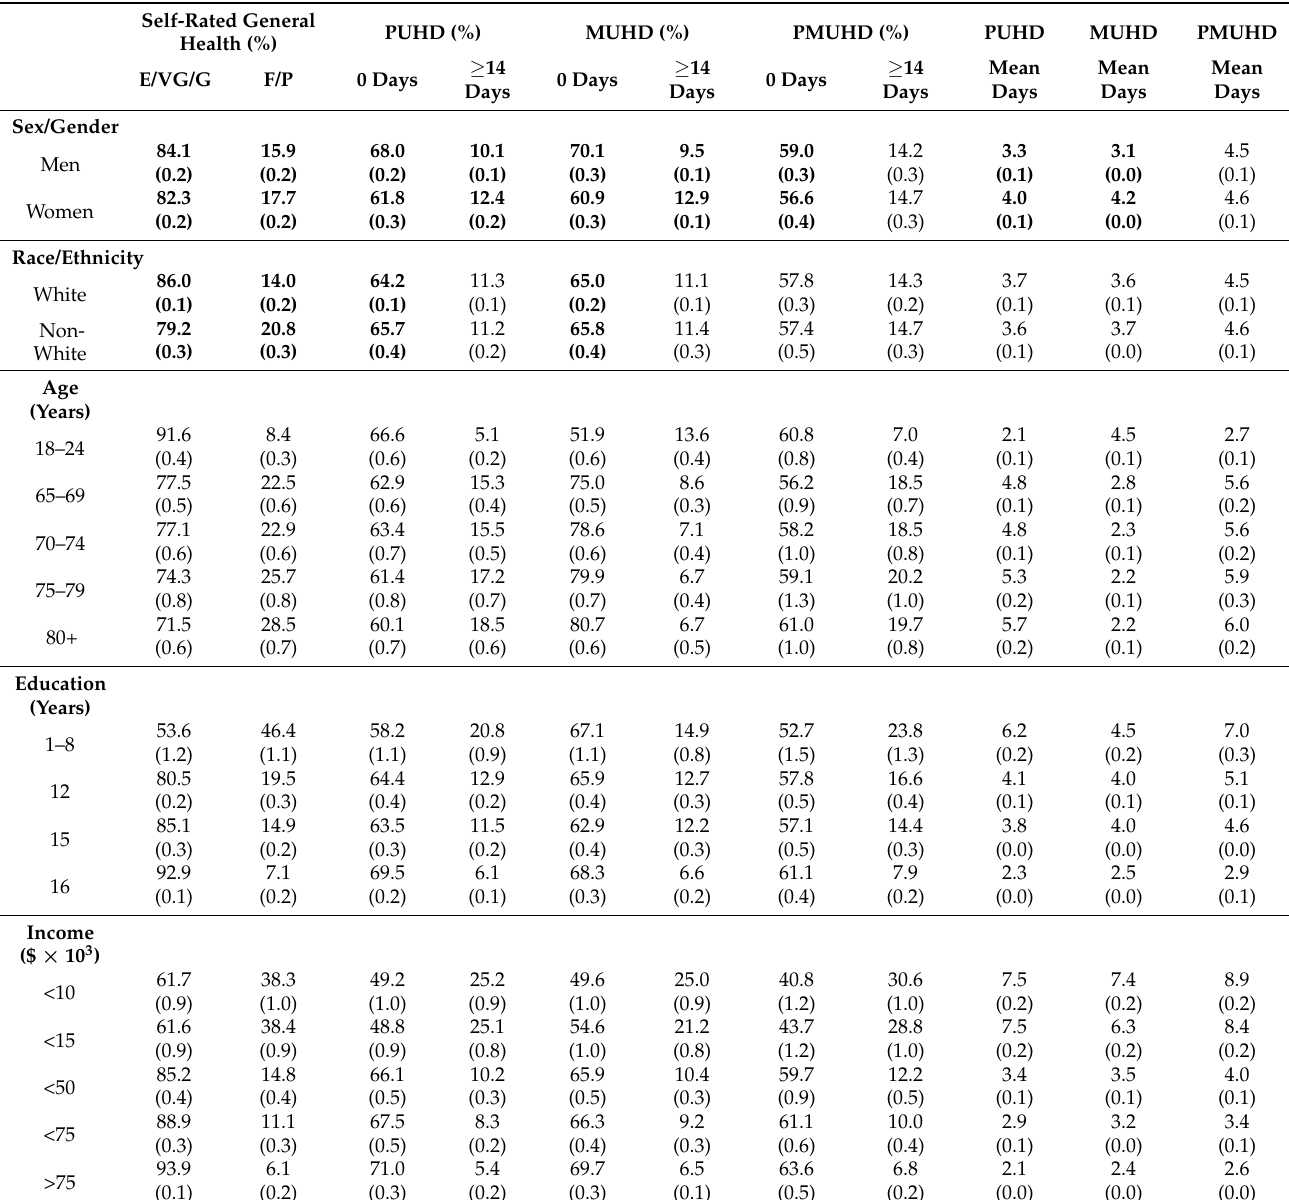
Table 7. Summary of general health and unhealthy days data by demographic categories for all MMSAs over all five years of the study. (See table notes for